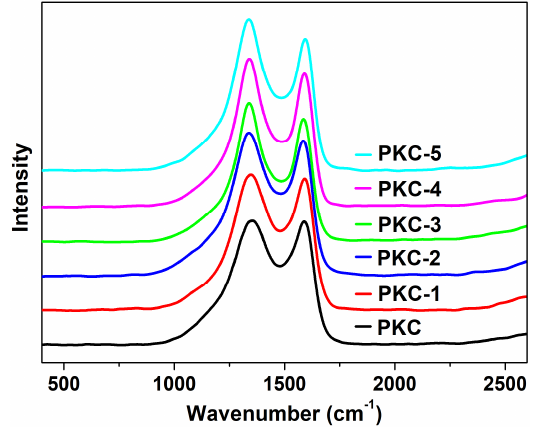
Figure 2. Raman spectra of biochars.